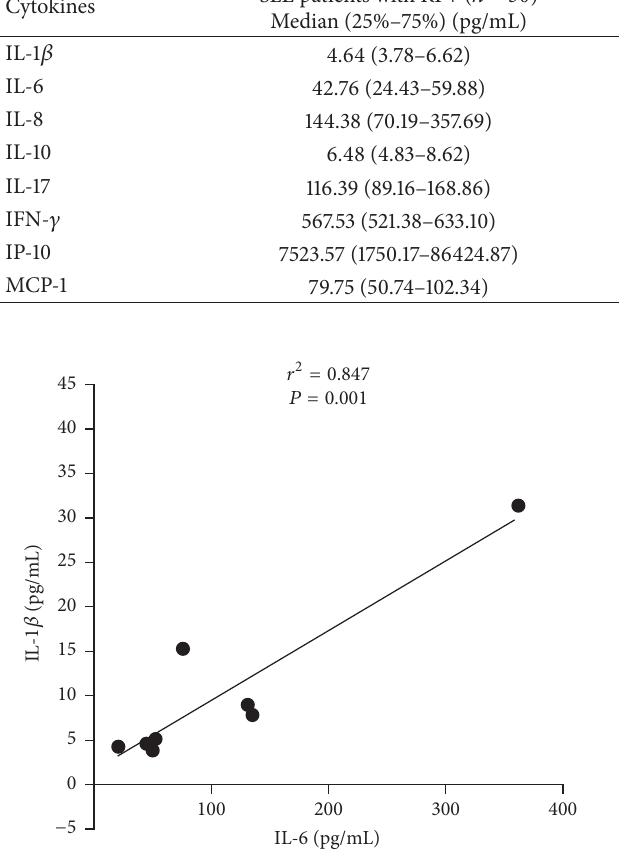
Figure 5: Association between IL-6 and IL-1 𝛽 for RF+IgE+ SLE